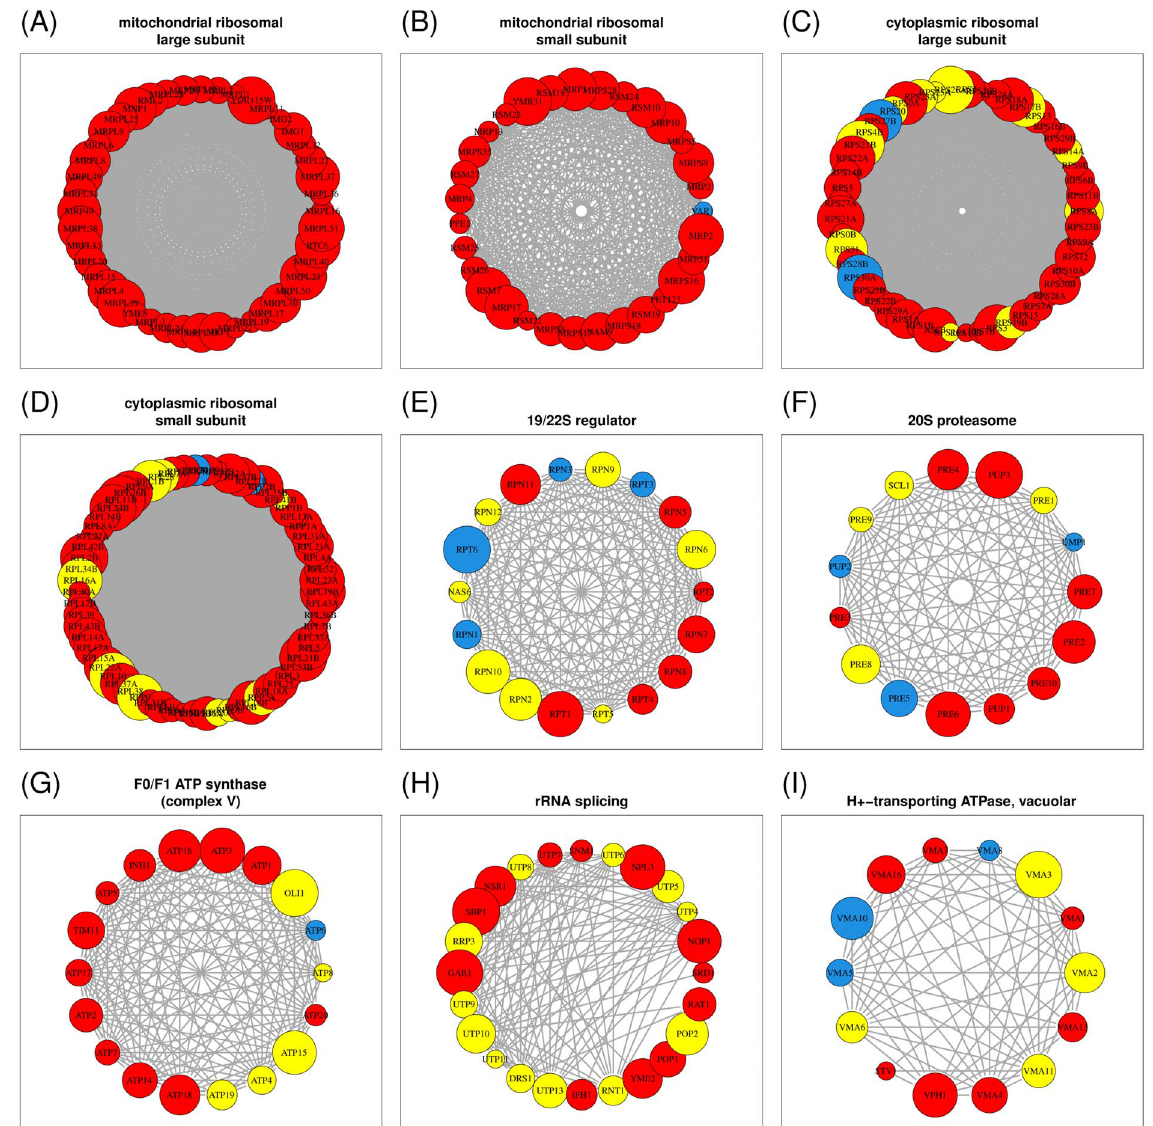
Figure 7. Visualization of networks of nine highly coexpressed MIPS protein complexes. A colored node represents a gene and the radius of the node is proportional to the intensity or gene expression level. An edge between two nodes indicates that a gene pair is coexpressed. A red node reflects a periodically expressed gene identified by both Tu et al. and EMD. A yellow node indicates a periodically expressed gene identified by EMD, but not by Tu et al. A blue node indicates a periodically expressed gene identified by neither Tu et al. nor EMD.